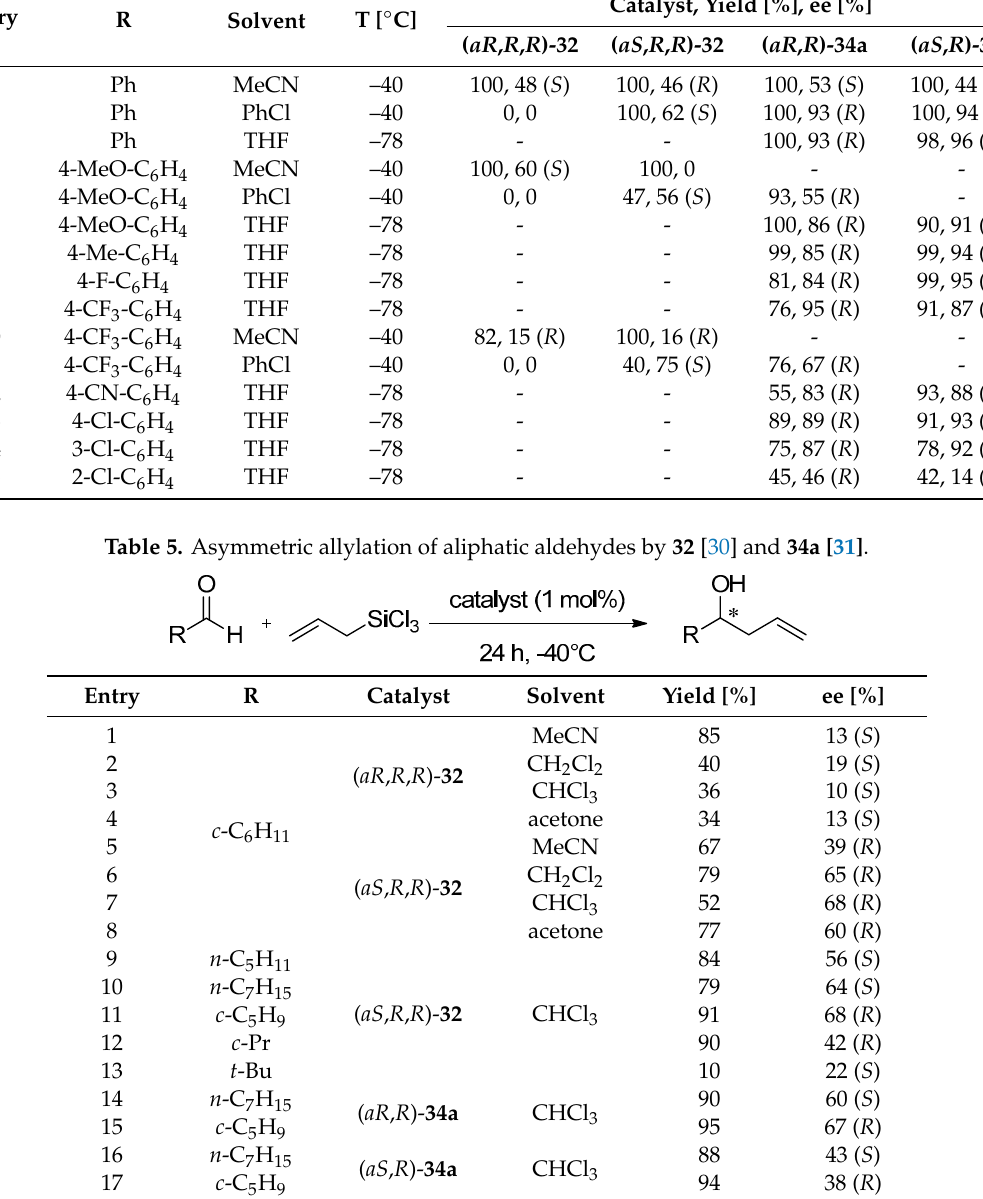
Table 4. Asymmetric allylation of aldehydes by 32 [50] and 34a [31] .